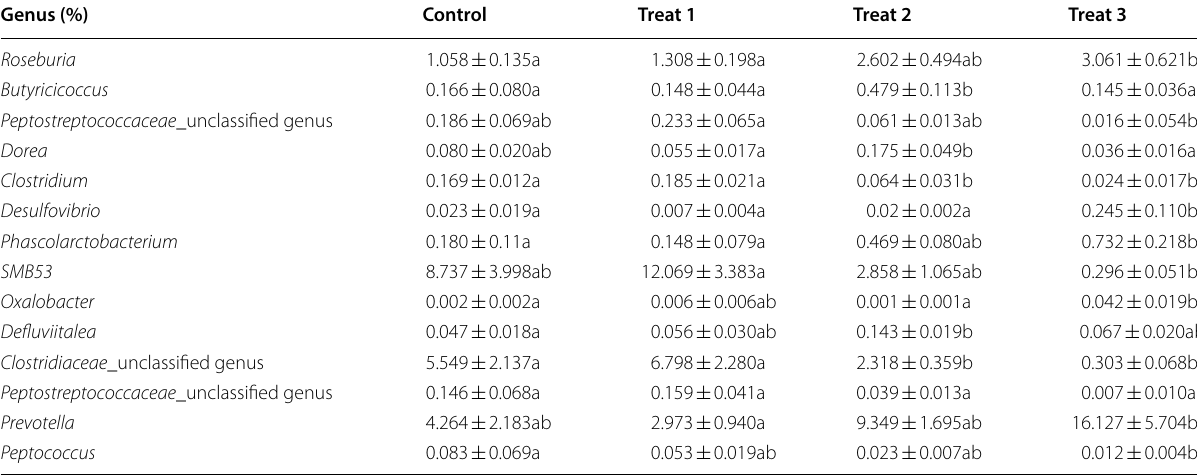
Table 4 Comparsion of mean relative abundance of bacterial genera among groups